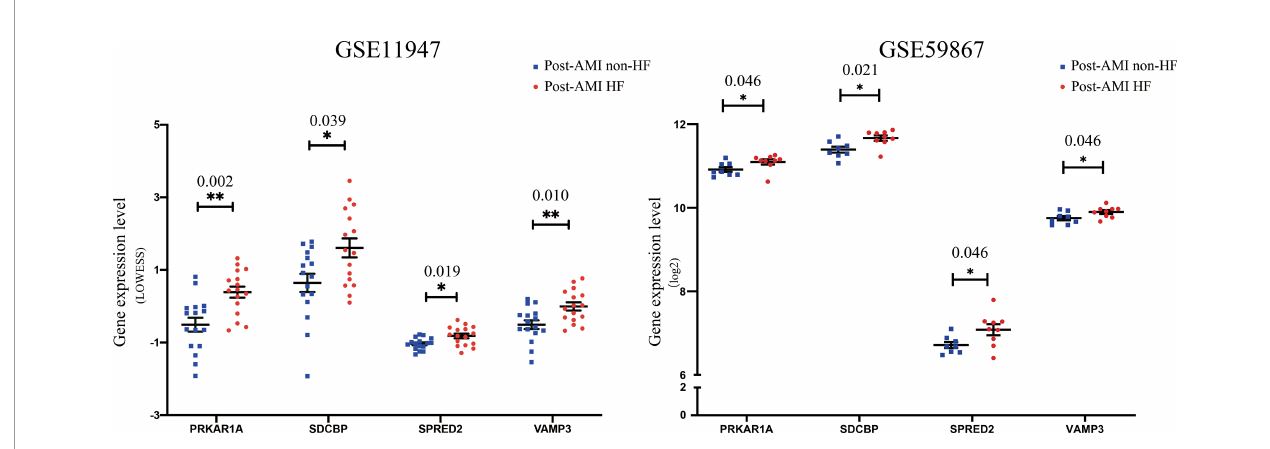
FIGURE 3 | Validation of the expression levels of key bio-correlated genes in post-AMI HF and post-AMI non-HF patients based on GSE11947 and GSE59867 datasets. GSE11947: HF n = 16, non-HF n = 16; GSE59867: HF n = 9, non-HF n = 8. P-value was shown above the asterisk (*). *P < 0.05, **P < 0.01. Data are presented as mean ± SEM. AMI, acute myocardial infarction; HF, heart failure; SEM, standard error of